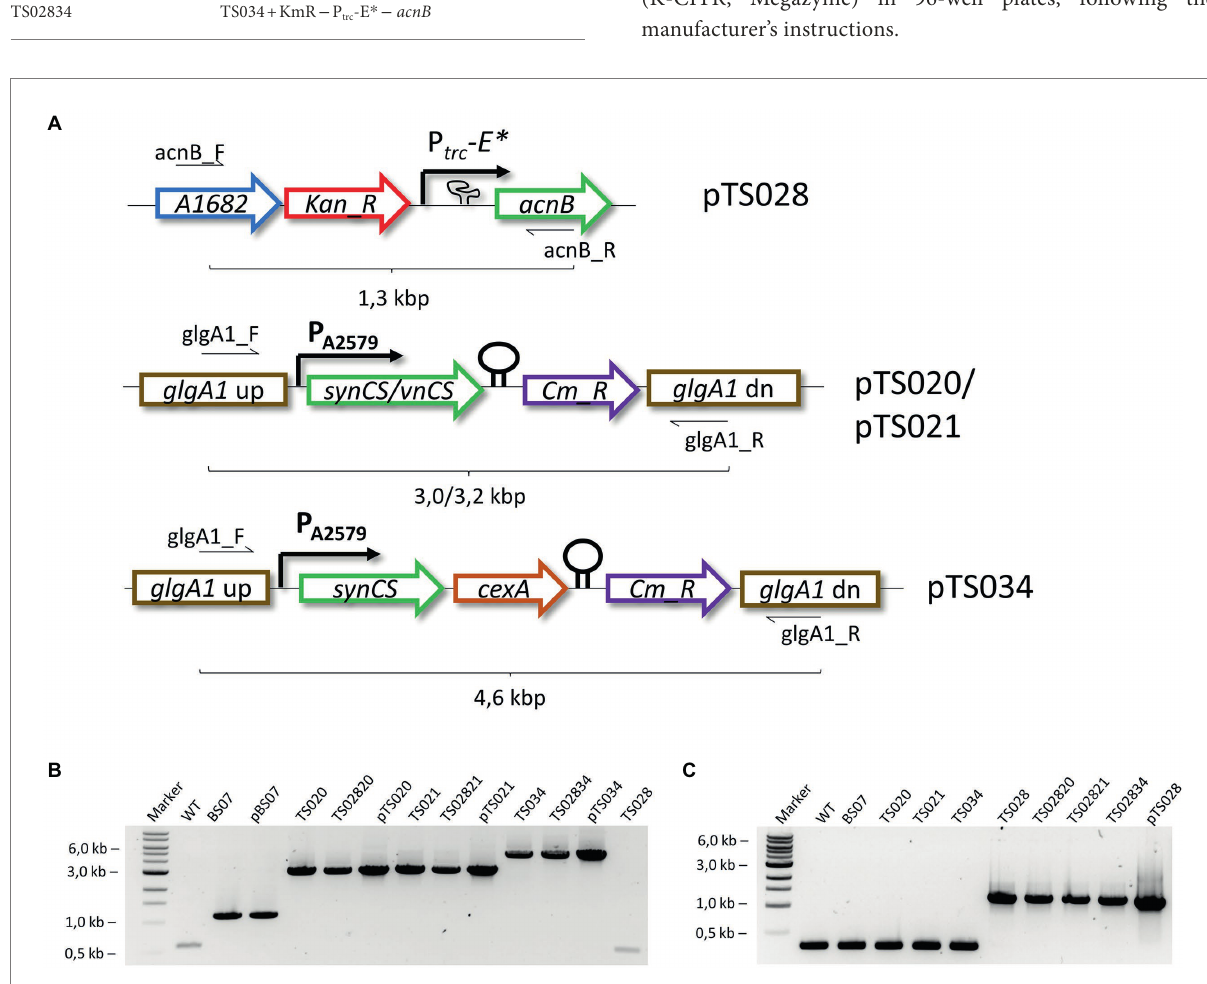
FIGURE 2 Generation of citric acid producing strains. (A) Simplified overview of modified Syn7002 loci for citrate production. Kan_R – kanamycin resistance cassette; synCS – Synechocystis sp. PCC 6803 citrate synthase gene; vnCS – Vibrio natriegens citrate synthase gene; Cm_R – chloramphenicol resistance cassette. (B) Genomic DNA PCR analysis of generated strains, using glgA1_F and glgA1_R primers. (C) Genomic DNA PCR analysis of generated strains, using acnB_F and acnB_R